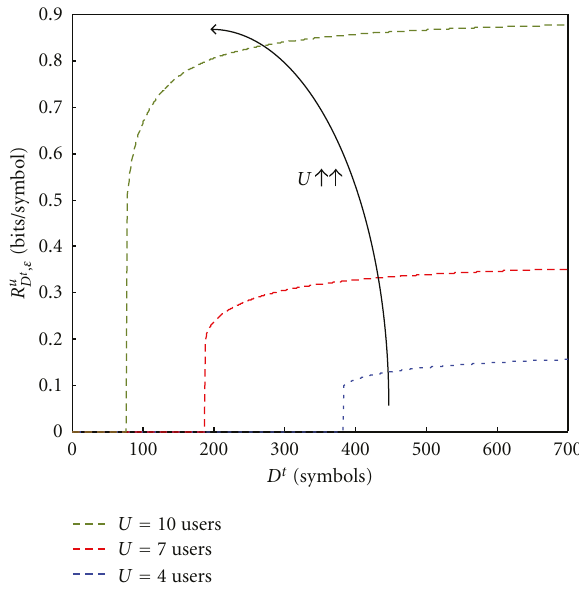
Figure 4: Multiuser diversity for BC and uncorrelated channel: maximum achievable rate of the median user. Average SNR following lognormal shadowing with mean 10 dB and standard deviation 4dB. ε = 0 . 1. β u =